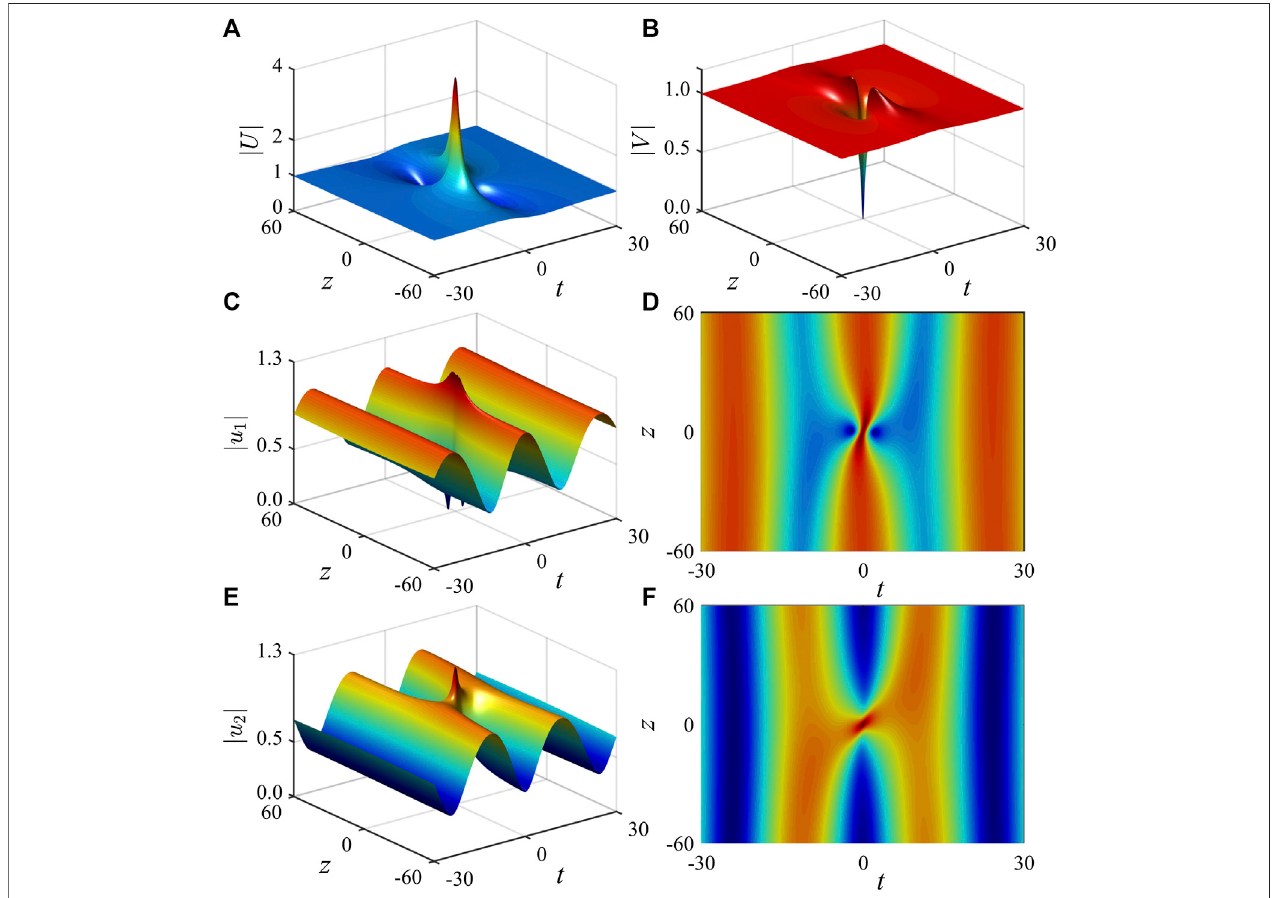
FIGURE 3 | Peregrine solitons on a periodic background formed in the normal dispersion regime ( σ (cid:2) − 1), de fi ned by the solutions Eqs 5 , 17 , and 18 , under the parameters c (cid:2) 1, a 1 (cid:2) 4 / 9, a 2 (cid:2) 4 (E) show the surface plots of Peregrine solitons for the u 1 and u 2 fi elds, respectively, with their corresponding contour plots given in (D) and (F) .